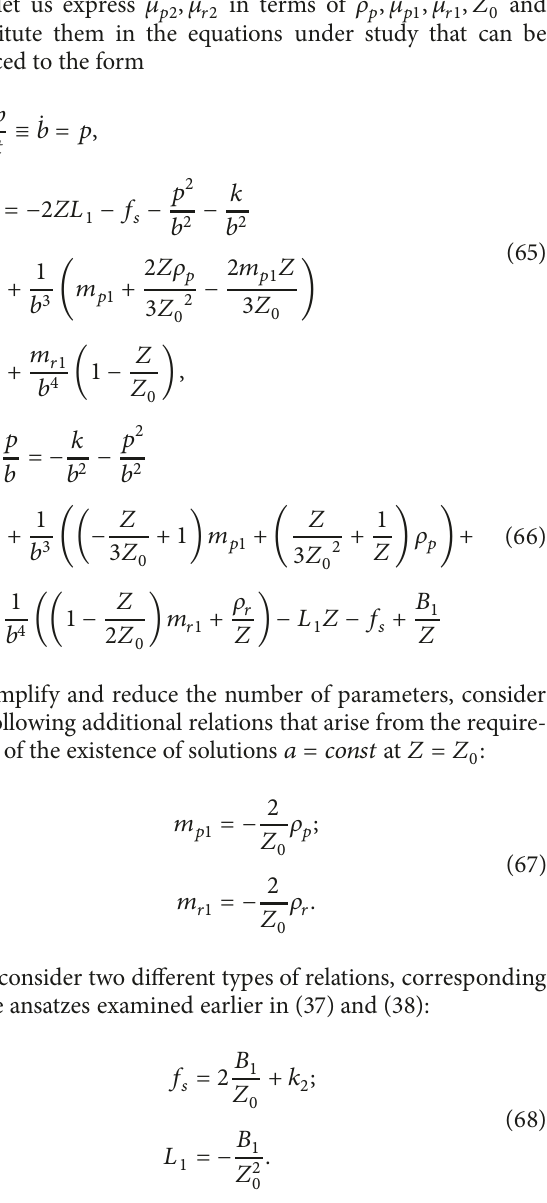
𝑚 is current age of the Universe; = 0 2